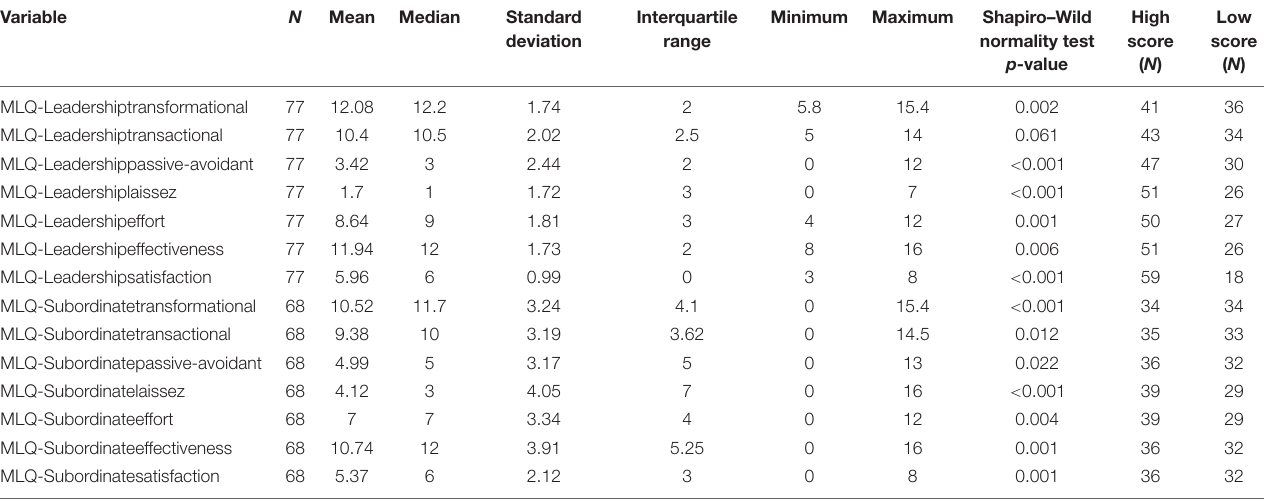
TABLE 4 | Description of the scores obtained by the participants in each of the MLQ-Leadership and MLQ-Subordinate subscales. Variable N Mean Median Standard